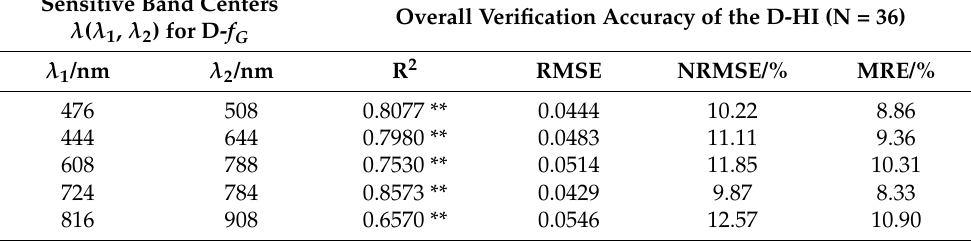
Figure 11. Establishment of the D-HI estimation model based on D- f G . Table 4. Overall verification accuracy of the D-HI estimation model based on D- f G remote sensing